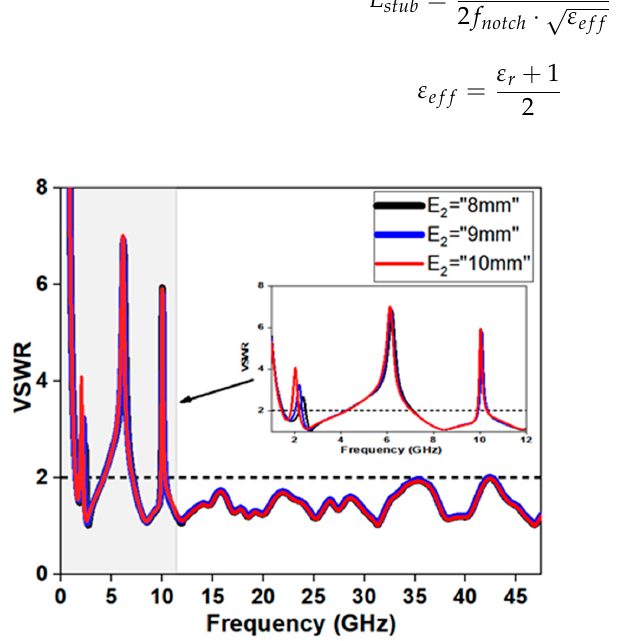
Table 2 . Parametric variation of notched bands .